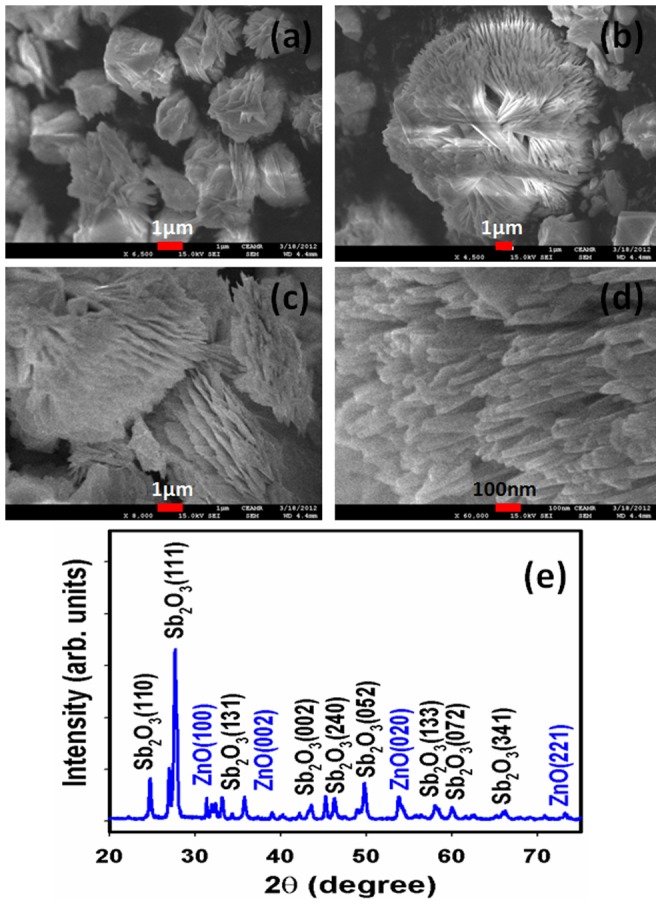
(a–d) FE-SEM images and (e) Powder x-ray diffraction pattern, of as-grown Sb2O3-ZnO MFs at room conditions.